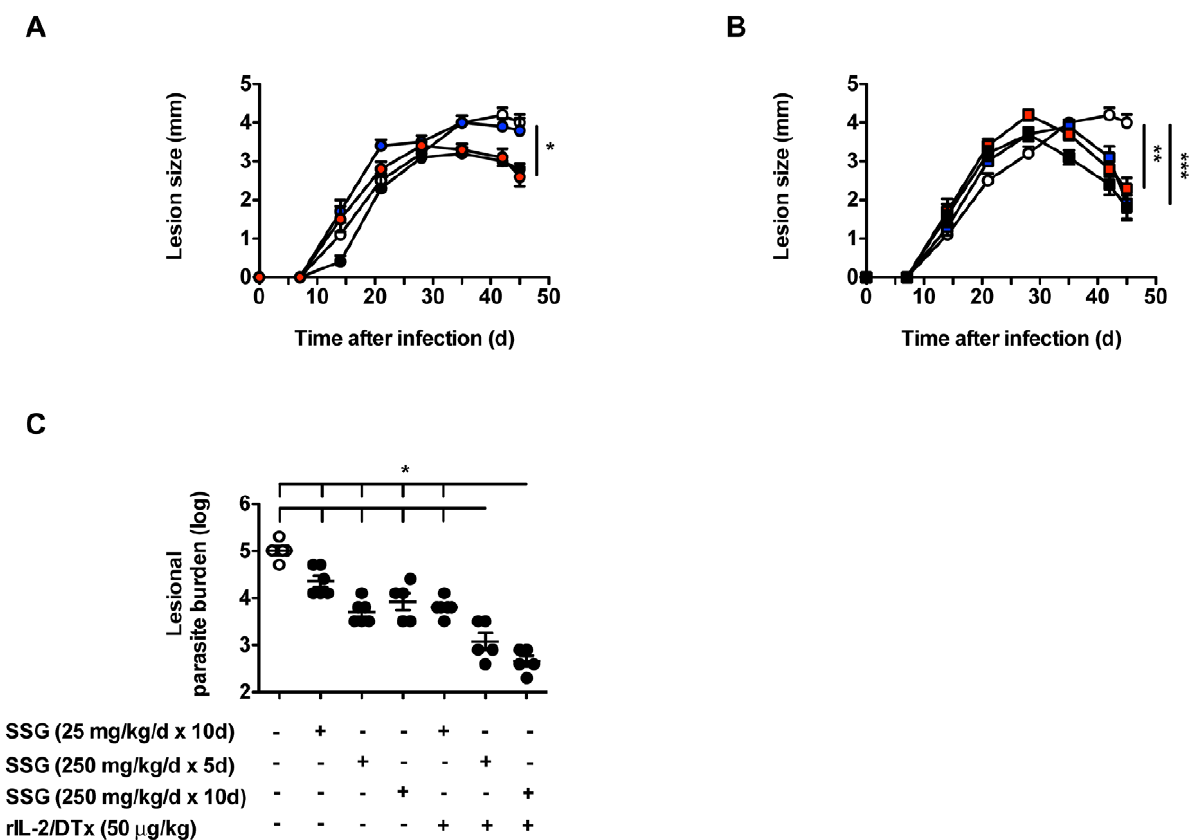
Figure 5. Addition of rIL-2/DTx to antibiotic therapy allows for treatment duration reduction in experimental cutaneous leishmaniasis. C57BL/6 mice were infected as in Figure 2. ( A and B ) lesion size. Beginning 30 d after infection, mice were treated as follows: (1) SSG 250 mg/kg daily for 10 d [black circles]; (2) SSG 25 mg/kg daily for 10 d [blue circles]; (3) SSG 250 mg/kg daily for 5 d [red circles]; (4) SSG 250 mg/kg daily for 10 d + rIL-2/DTx 50 m g/kg 3 times at 5 d intervals [black squares]; (5) SSG 25 mg/kg daily for 10 d + rIL-2/DTx 50 m g/kg 3 times at 5 d intervals [blue squares]; (6) SSG 250 mg/kg daily for 5 d + rIL-2/DTx 50 m g/kg 3 times at 5 d intervals [red squares]; (7) normal saline (per route and schedule for 10 d SSG plus 3 doses of rIL-2/DTx) [open circles]. Note, while regimens are separated into 2 panels for ease of visibility, the control (saline) group in both panels is one and the same. ( A and B ) MANOVA P , 0.0004; ANOVA P , 0.001; Tukey’s correction; * P , 0.05, ** P , 0.01, *** P , 0.001. Linear random effects modeling, done in a second order of analysis, rejected the null hypothesis of all treatments having equal effects ( P , 0.001), and sorted